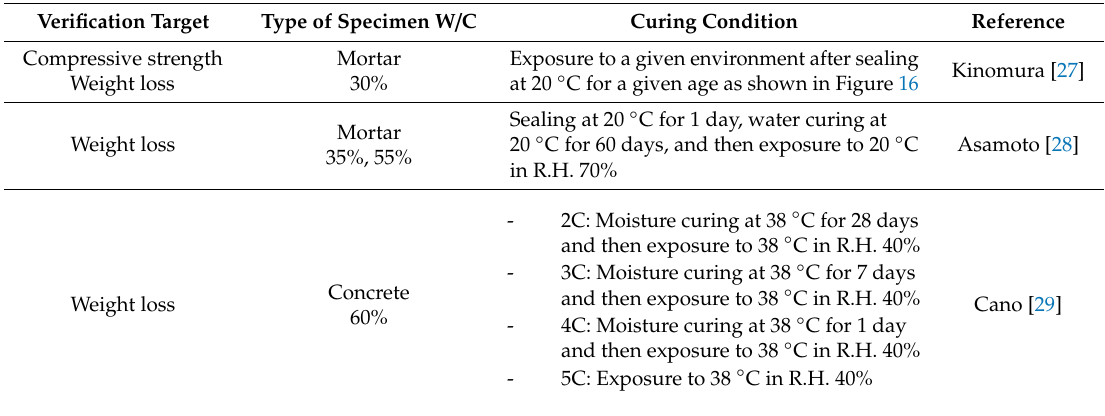
Table 4. Experimental conditions in the past studies.